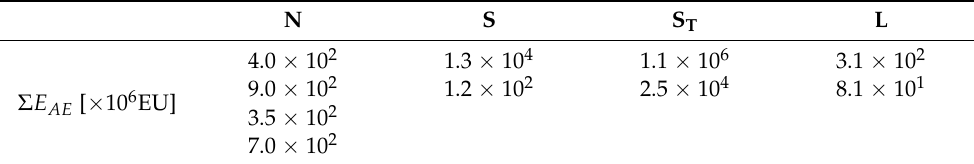
Table 2. Cumulative energy Σ E AE .